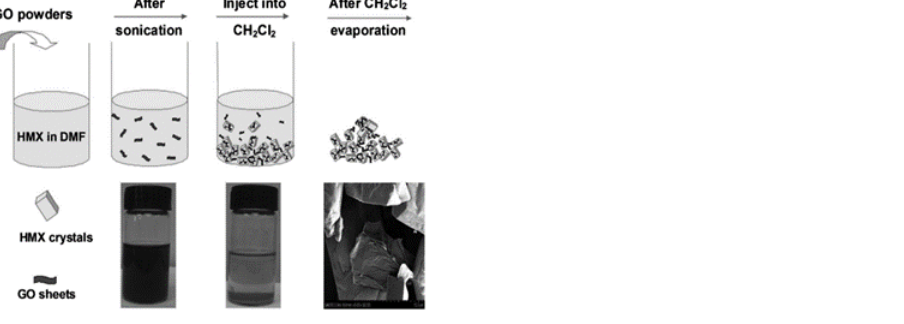
Figure 5. The production scheme of HMX/graphene composite material. Figure 4. The production scheme of HMX/graphene composite material. Reprinted with permission from ref. [24]. Copyright 2013 John Wiley and Sons.